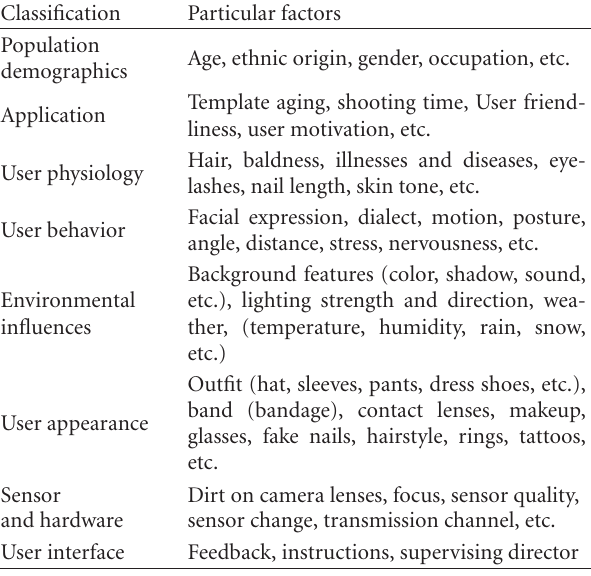
Table 1: Classification of factors a ff ecting the performance of bio- metric